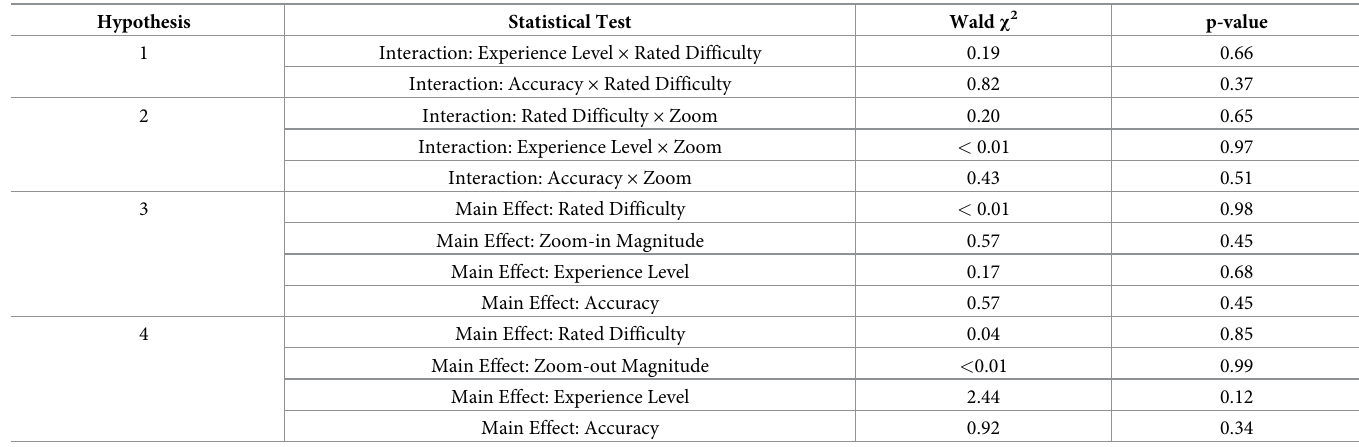
Table 3. Statistical test results.